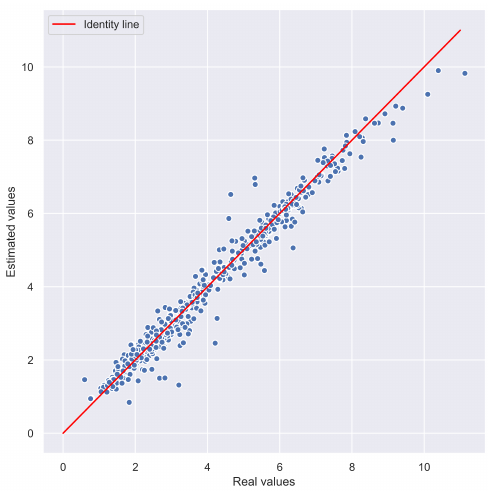
Figure 6. Scatter plot showing the relationship between real and estimated ET 0